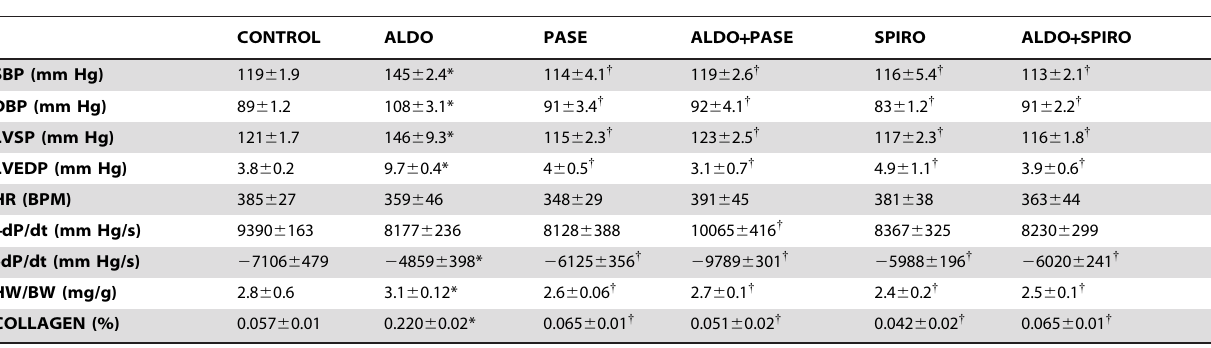
Table 2. Hemodynamic parameters and collagen content.